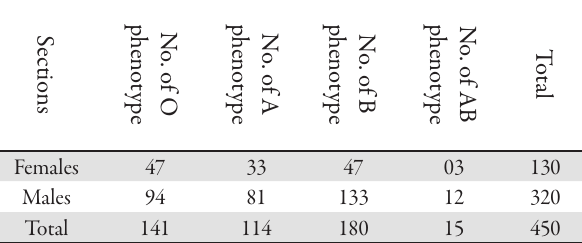
Tab. 7. Gender wise distribution of ABO blood group among Maurya population